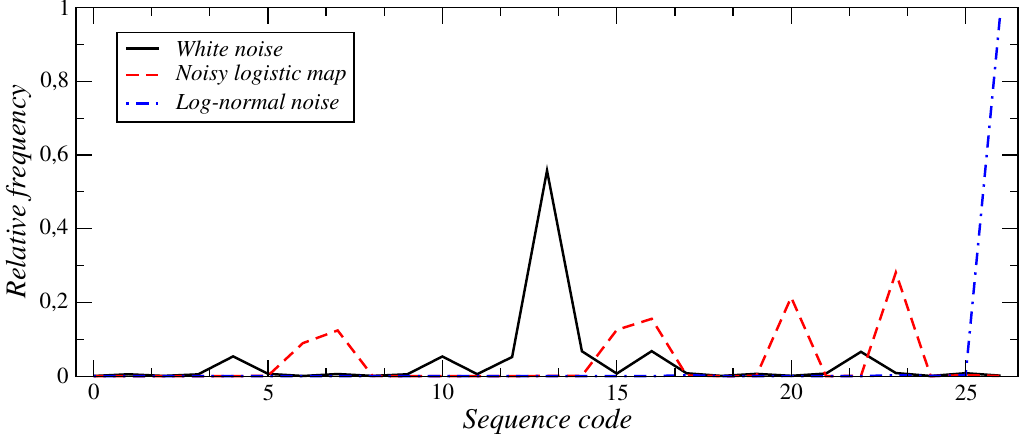
Figure 9. Symbol sequence histograms (SSHs) for the random processes plotted in Figure 8, for n = 3 and L =